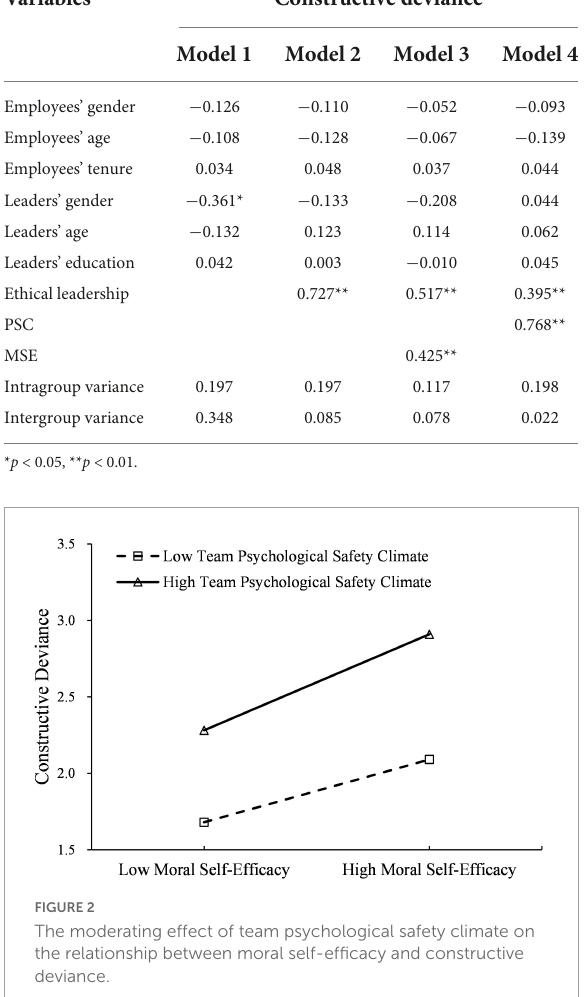
TABLE 3 Hypothesis test statistics.